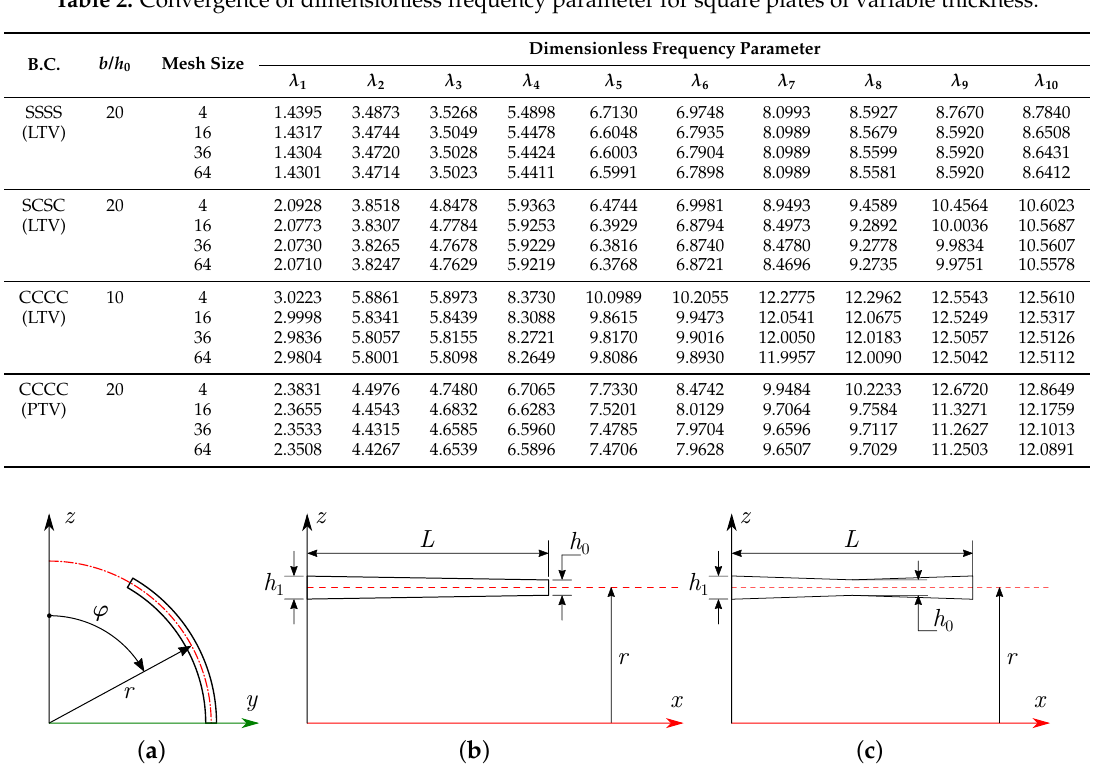
Table 2. Convergence of dimensionless frequency parameter for square plates of variable thickness.